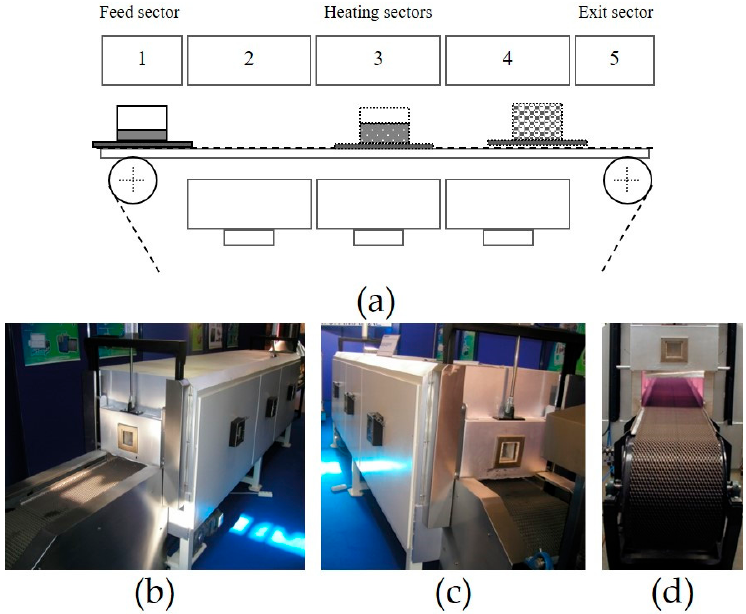
Figure 2. Scheme ( a ) and photos of the continuous foaming furnace belt, showing the feed ( b ) and exit ( c ) sectors and the conveyor belt ( d ).